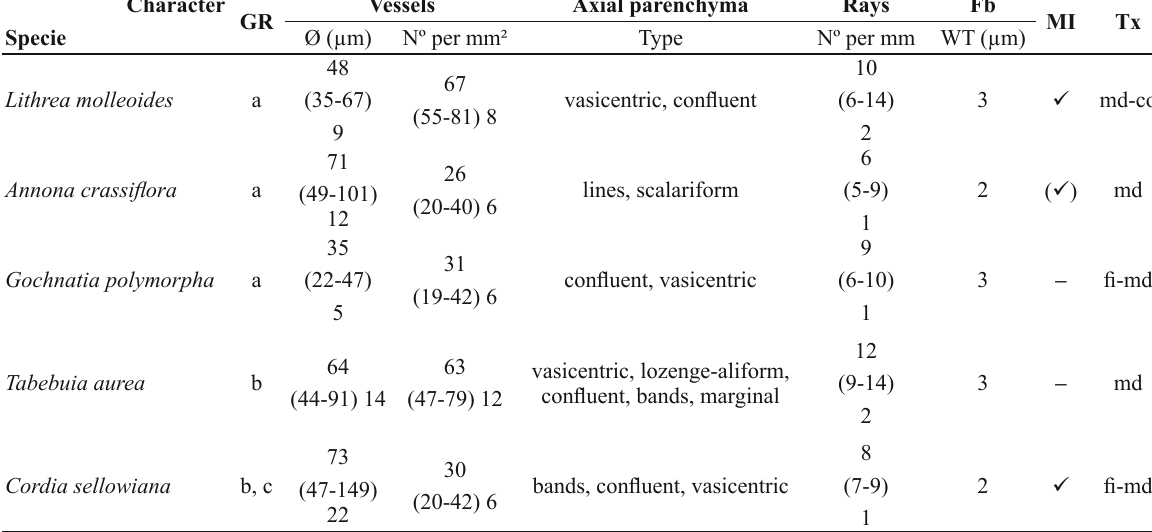
Growth rings and anatomical features of the species studied. Numbers are related to the fi gures presented above. GR = growth rings. a = fi ber zones. b = marginal lines/bands of axial parenchyma. c = semi-ring porosity. d = marked by closeness of the narrow bands of scalariform parenchyma. e = variations within growth layers in the axial parenchyma, where the long aliform con fl uent parenchyma tends to form irregular bands. – = absent or indistinct. Ø= vessel tangential diameter. Fb = Fibers. WT = fi ber wall thickness. MI = mineral inclusions.  = present. ( ) = rare or few. – =